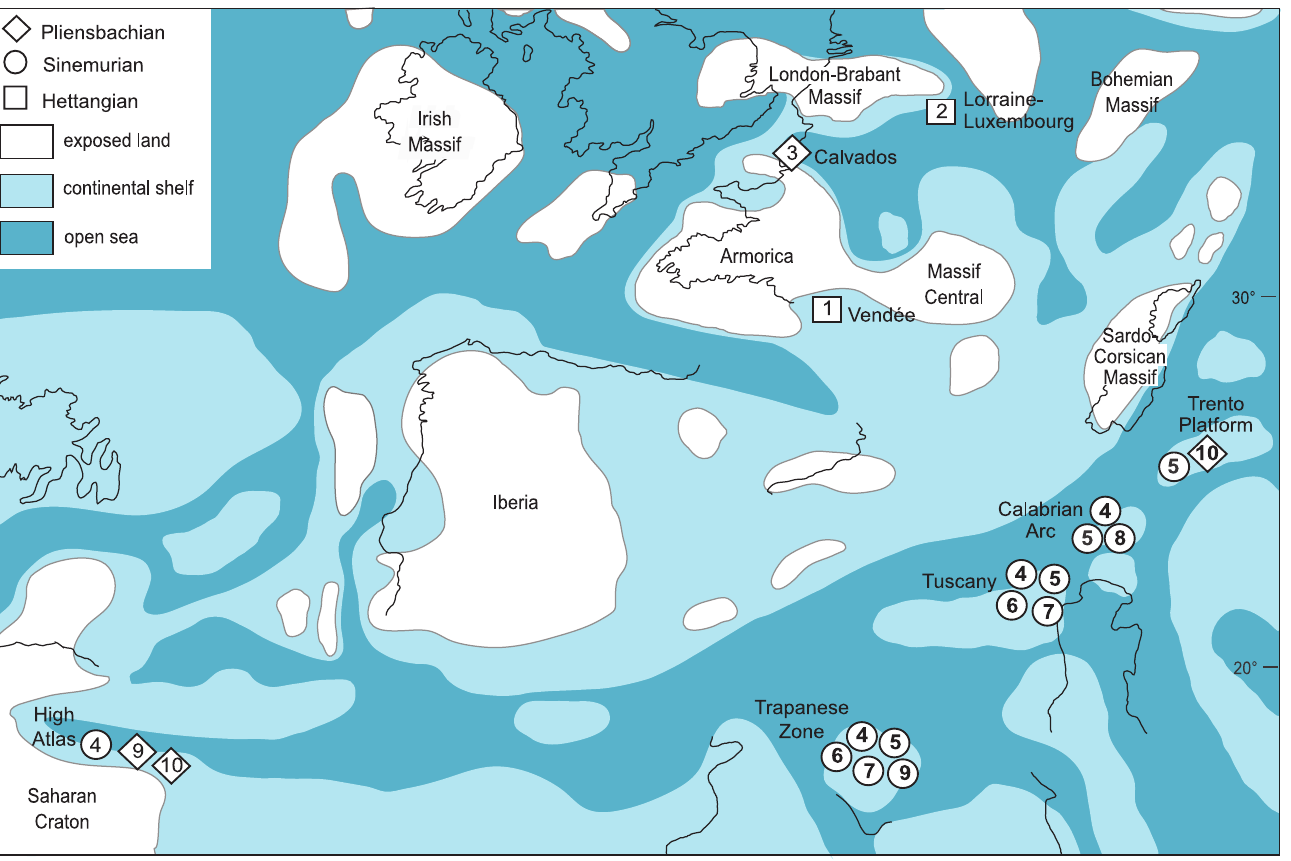
Fig. 7. Early Jurassic palaeogeographical distribution of the Zygopleura ­like species listed in Table 1. Map simplified from the late Sinemurian map of Dercourt et al. (2000). Abbreviations: 1, Zygopleura vinosimonensis ; 2, Melania theodori ; 3, Zygopleura subnodosa ; 4, Chemnitzia tatia ; 5, Chemnitzia polyplecta ; 6, Chemnitzia moorei ; 7, Chemnitzia veturia ; 8, Chemnitzia catacyclus ; 9, Chemnitzia appenninica ; 10, Chemnitzia paradisi